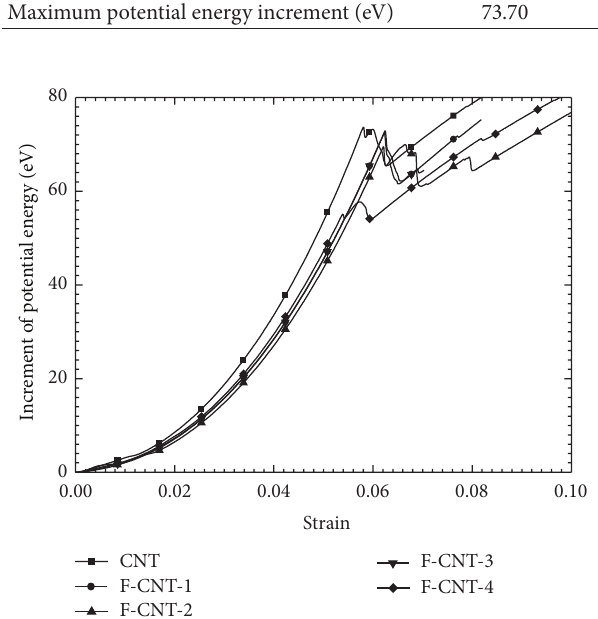
Figure 6: Variation of potential energy increment versus strain of CNTs with different functionalized configurations.